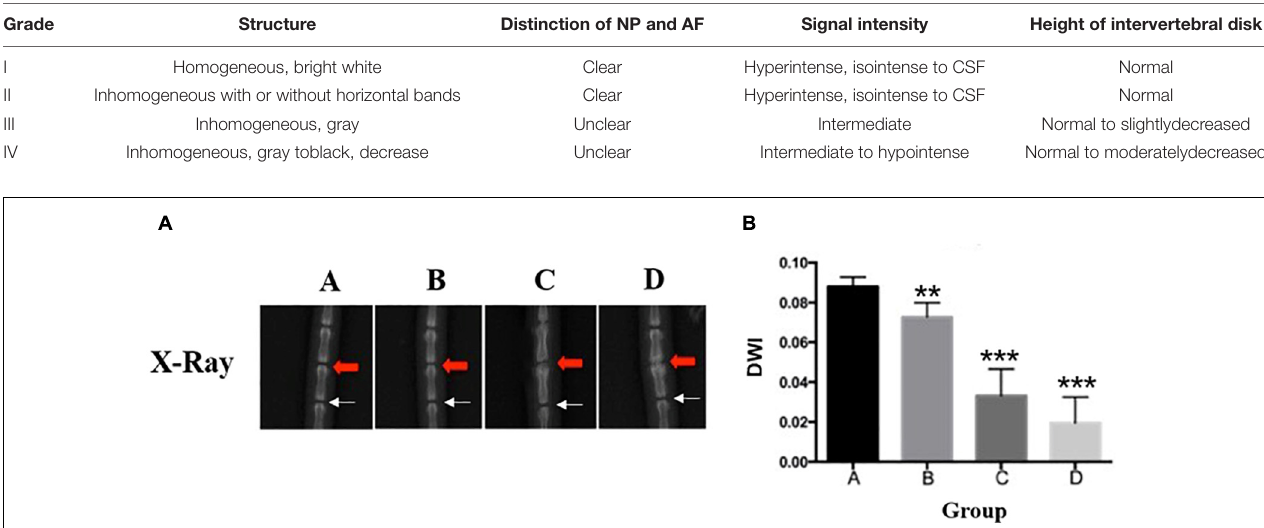
test for comparison between control and treatment